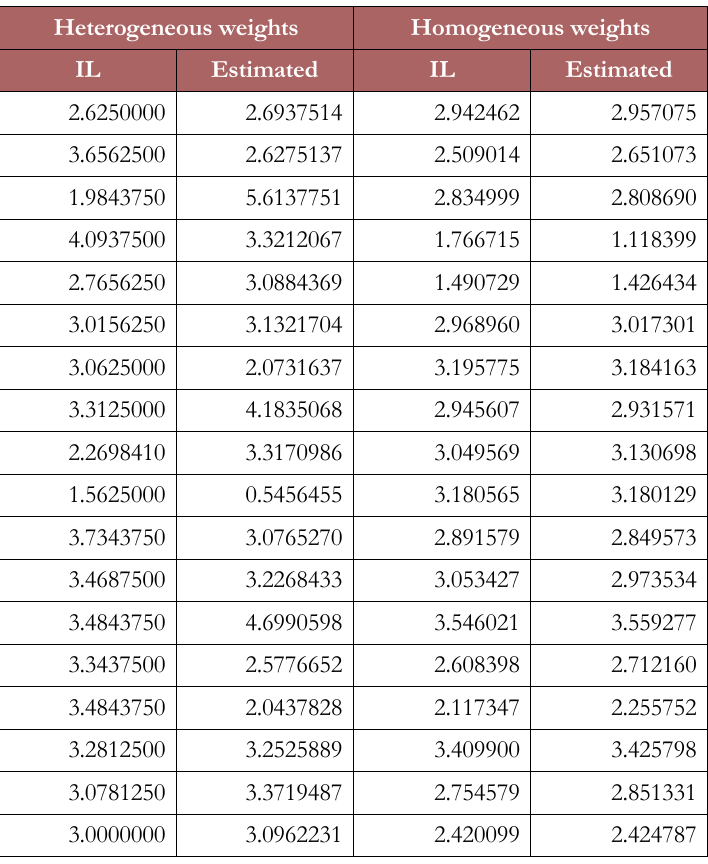
Table 4. Resulting variable NI with heterogeneous and homogeneous weights